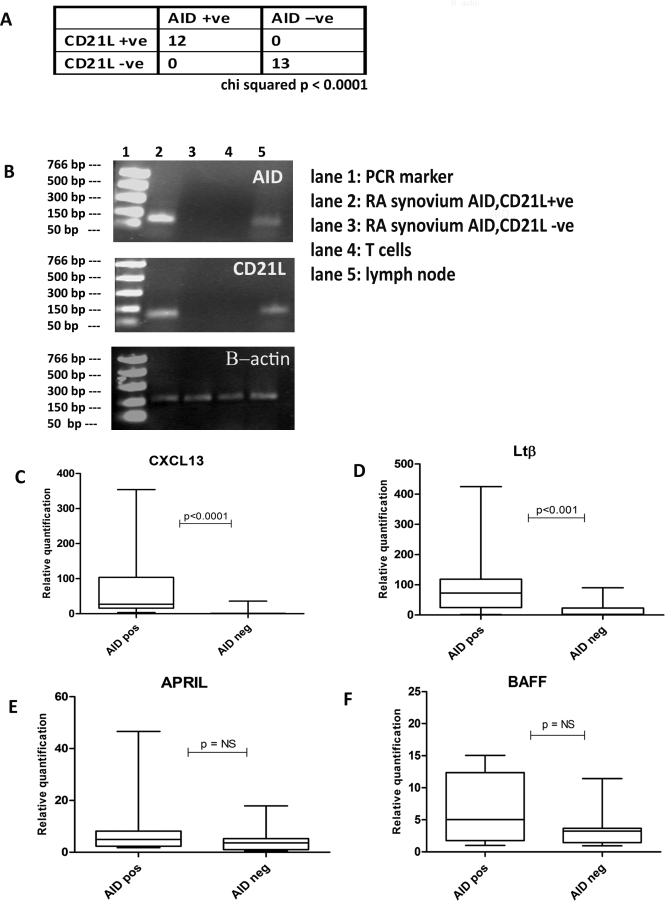
AID mRNA within Rheumatoid Synovial Tissue Is Expressed Exclusively in Association with CD21L-Isoform TranscriptsQT-PCR was used to measure levels of transcripts of AID and CD21L in synovial samples from 25 patients with RA. Results were normalized for the endogenous control (human β-actin) and expressed as relative quantification.(A) The presence of AID is restricted to those tissues expressing CD21L.(B) Representative examples of the PCR products were run in a 1.8% agarose gel to ensure the presence of a single specific amplification product and confirm specficity of QT-PCR. Amplicons of the expected length (99 bp for AID and CD21L and 171 bp for β-actin) were observed in samples that gave positive signals at QT-PCR (lane 2), while no bands were detected in samples negative for AID/CD21L by QT-PCR (lane 3). No AID/CD21L amplification was detectable in negative controls (CD3-sorted cells, lane 4), while AID and CD21L were both detectable in control human lymph node (lane 5).(C–F) CXCL13, LTβ, BAFF, and APRIL transcript analysis by QT-PCR. AID expression within synovial tissue was associated with the up-regulation of both CXCL13 and LTβ but no significant difference was seen in the levels of APRIL and BAFF. The lower and upper margins of the box represent the 25th and 75th percentiles, with the extended arms representing the 10th and 90th percentiles, respectively. The median is shown as a horizontal line within the box. p-Values were calculated using the Mann-Whitney U test.